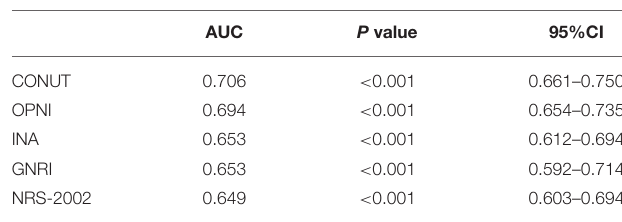
TABLE 2 | Comparison of AUC of different nutrition-related tools in predicting in-hospital